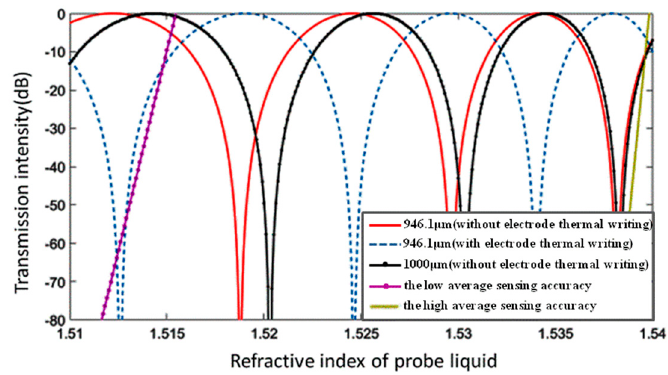
Figure 9. Transmission intensity of sensor with various length differences and core refractive indices.